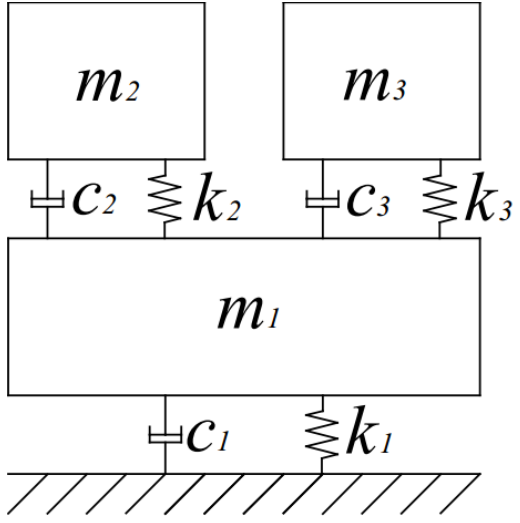
Figure 1. Schematic diagram of the simulated 3-DOF time-variant system.